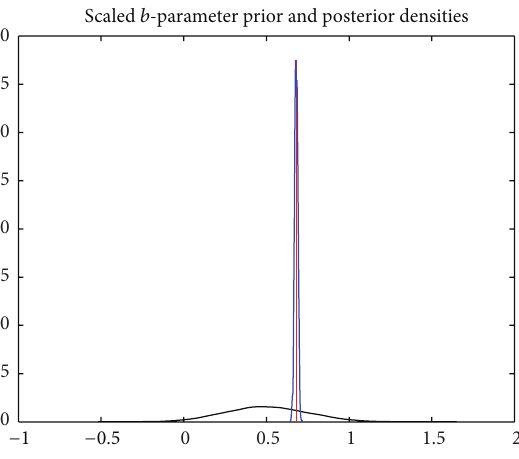
Figure 4: Scaled 𝑏 posterior samples.